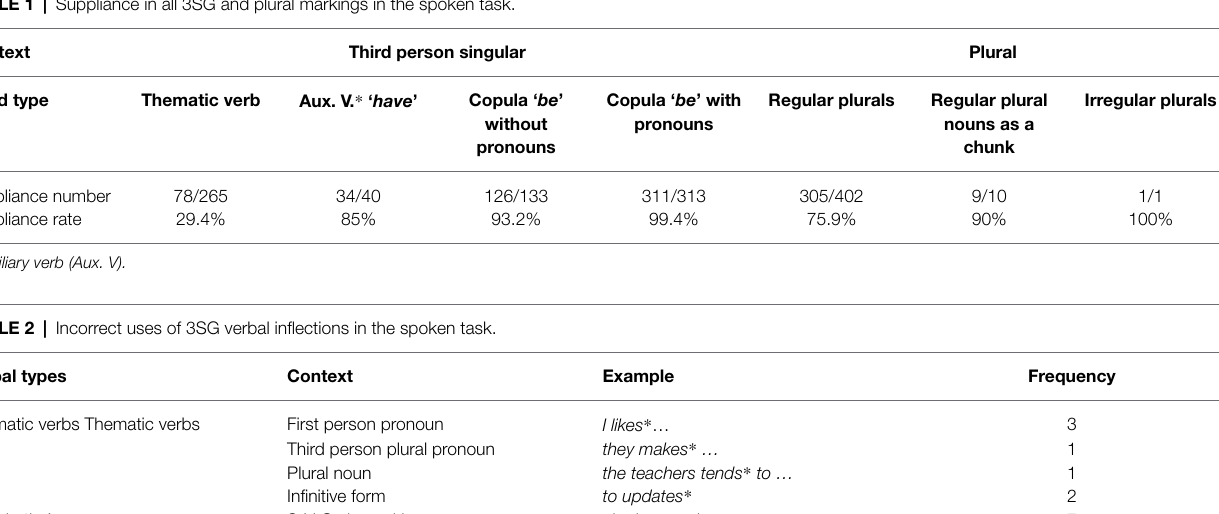
TABLE 1 | Suppliance in all 3SG and plural markings in the spoken task.